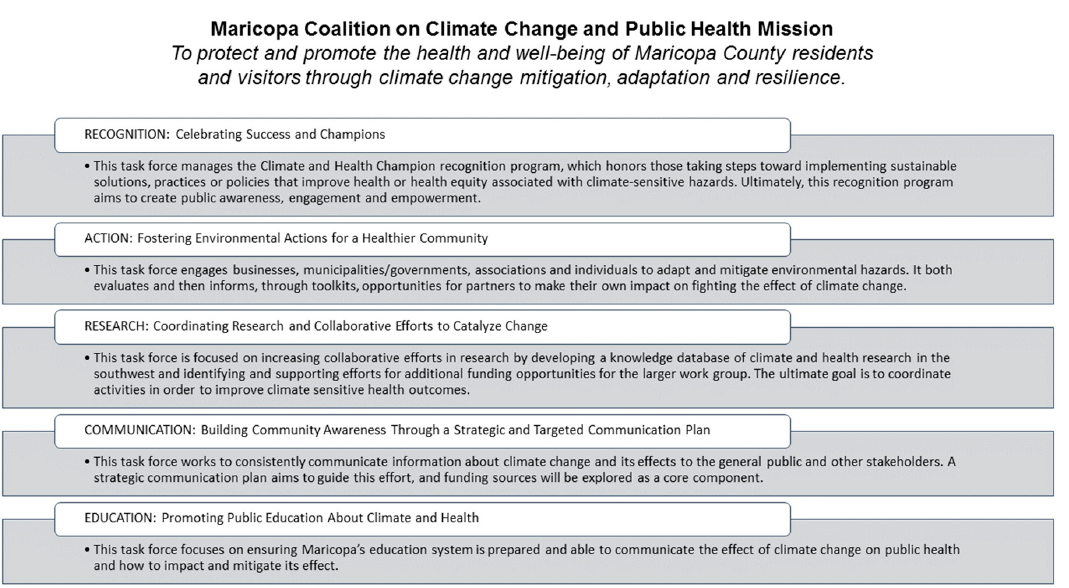
Figure 1. Maricopa County Department of Public Health (MCDPH) Coalition of Climate Change and Public Health Mission and Action Team descriptions.